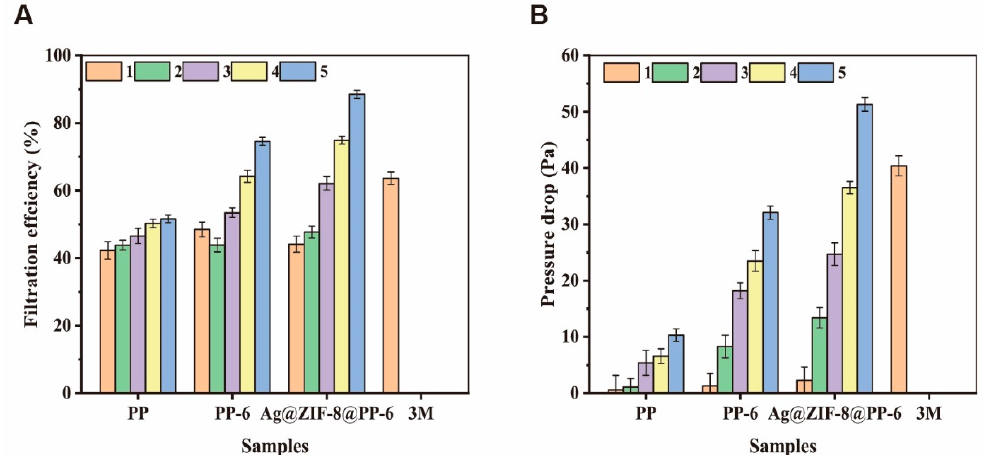
Figure 10. The test results of the filtration effect ( A ) and pressure drop ( B ) of various types of melt-blown nonwoven fabrics with different number of layers.